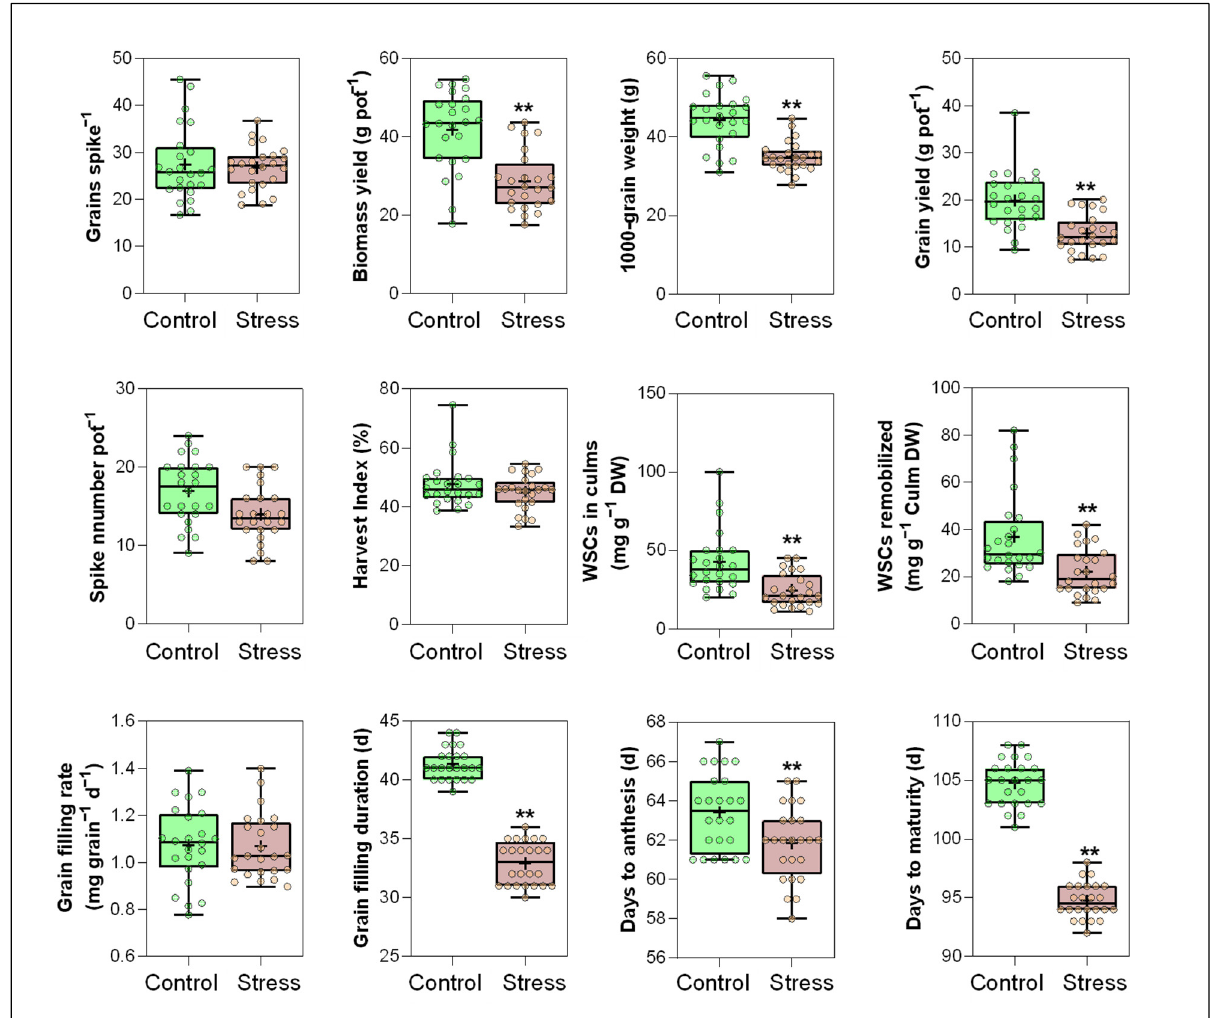
Figure 2. Box plots showing the descriptive statistics of different traits in pot-grown eight wheat cultivars under control and drought stress conditions during the grain-filling period. The horizontal line and + sign within the box represents the median and mean, respectively. The lower and upper limit of the box, lower and upper whisker represents Q1 (first quartile), Q3 (third quartile), (Q1 − 1.5IQR) and (Q3 + 1.5IQR), respectively. IQR—interquartile range. Open circle dots on the boxes indicate the distribution of observations. ** indicates significant variations between control and stress at 1% level of significances.